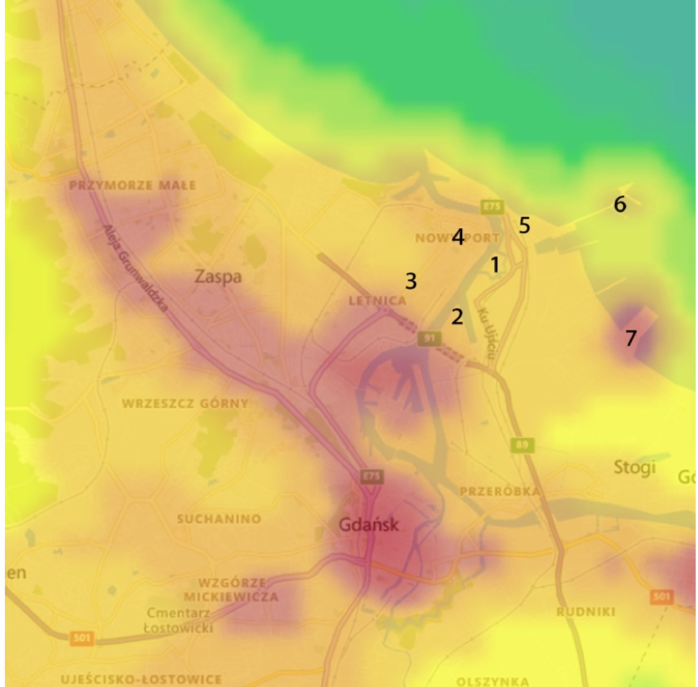
Figure 9. Locations of seven points for light pollution level analysis. Source: authors’ elaboration based on the graphics displayed by the LPM